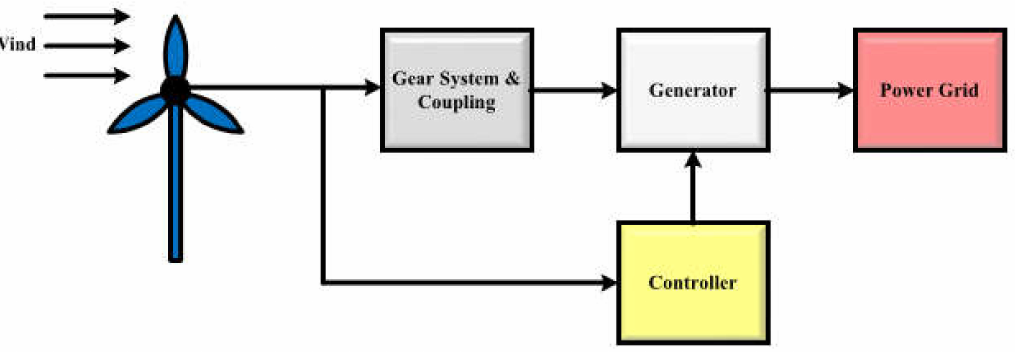
Figure 3. Wind Turbine-Based Single-Area Power